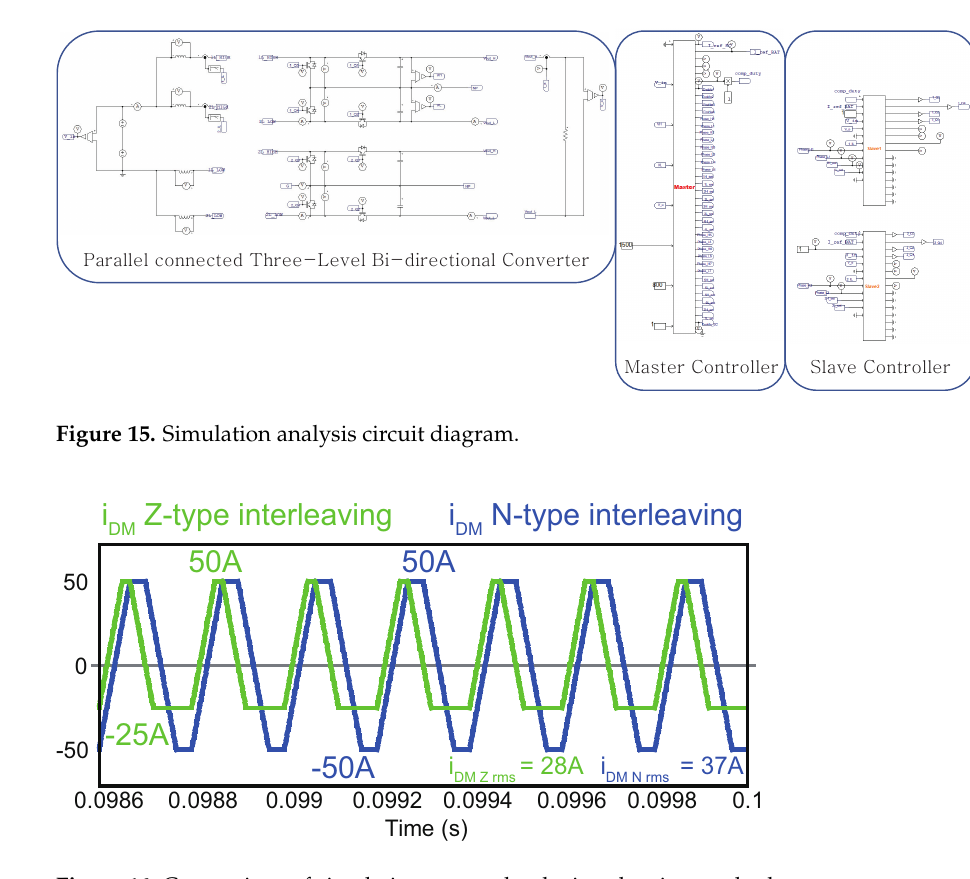
Figure 16. Comparison of circulating current by the interleaving methods.